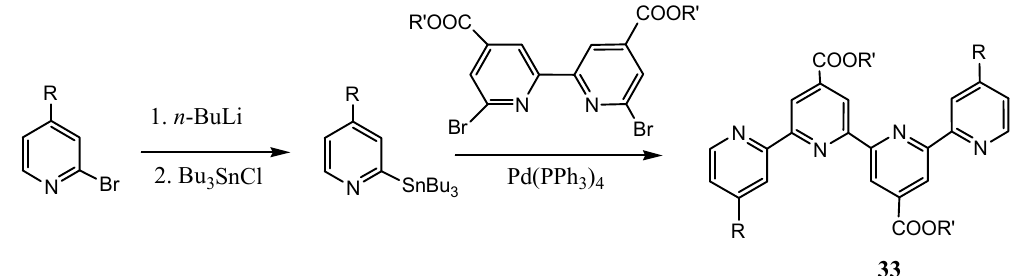
Scheme 14. Synthesis of carboxylated quaterpyridine ligands by palladium-catalyzed